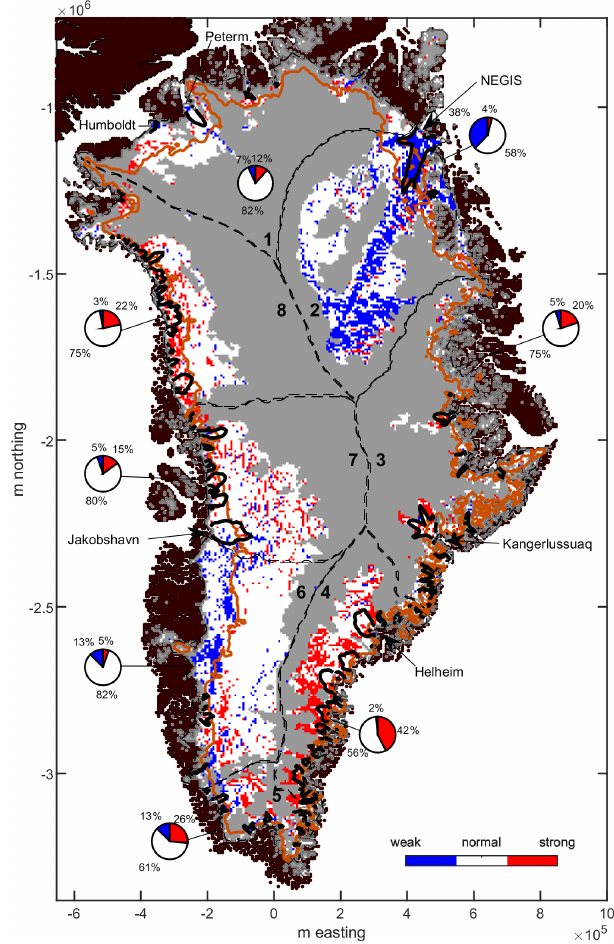
Figure 8. Map of weak- and strong-bed grid cells. Black contours indicate 200myr − 1 and identify concentrated regions of faster flow. Orange line delineates the average snowline from 2001 to 2017 (Vandecrux et al., 2019). Dashed lines delineate flow catchments. The small pie charts show the percentage of weak and strong re- gions within each